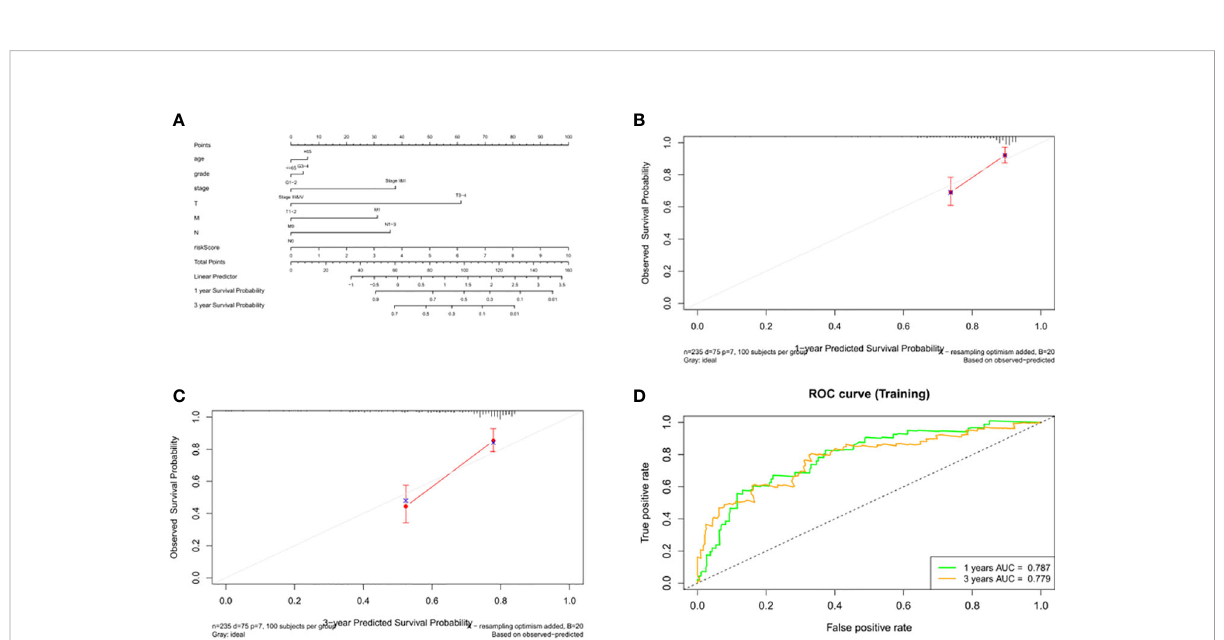
FIGURE 11 Construction and validation of the nomogram. (A) Calculation of the scores of each item of HCC patients according to the nomogram, and the total scores obtained after addition can predict the 1- and 3-year survival probability. (B, C) The 1- and 3-year calibration curves of the nomogram. (D) The ROC curves of the 1-and 3-year nomogram (AUC = 0.787 of 1 year, AUC = 0.779 of 3 years). The abscissa represents false positive rate, the ordinate represents true positive